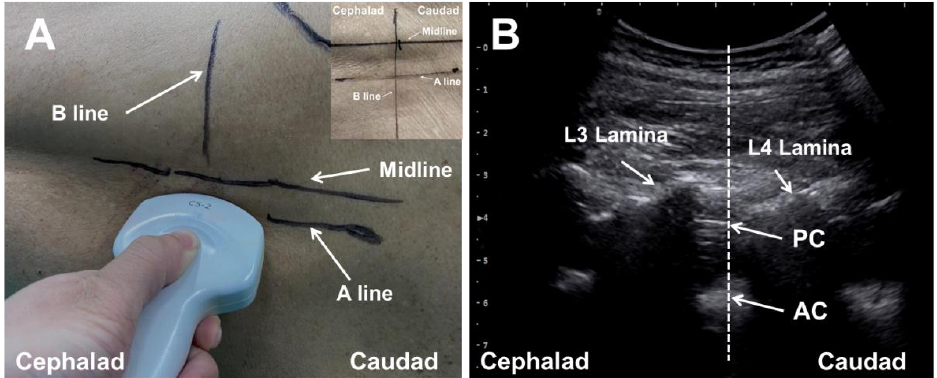
Figure 2. Single-plane ultrasonic scan-assisted positioning. The probe was placed at the lumbosacral region to perform the paramedian sagittal oblique scan (Panel ( A )). The scanning line (A line) and the perpendicular line corresponding to the midpoint of the probe (B line) were marked on the patient’s skin when the target intervertebral space was imaged on the midline of sonogram (Panel ( B )). The intersection point of A line and B line was the target puncture site for spinal anesthesia, which is illustrated in the upper right corner of the ( A ). AC, anterior complex; PC, posterior complex. For patients in Group B, we used both the paramedian sagittal oblique scan and the paramedian transverse oblique scan techniques to identify the puncture sites. We first performed the paramedian sagittal oblique scan as described in Group A. Following the identification of the preferred and secondary puncture gaps, only the scanning line of the probe was marked on the patient ’ s skin (Figure 3A,B).